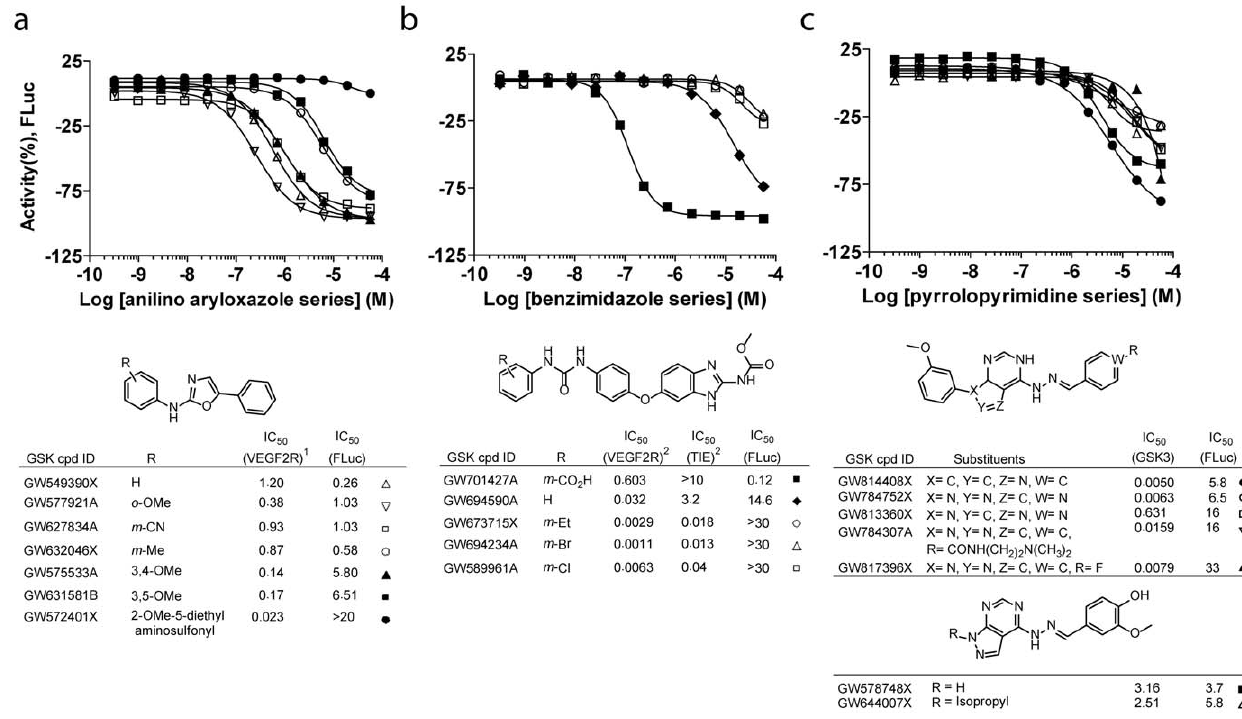
Figure 3. Representative PKIS series displaying FLuc inhibition. ( a ) Anilino-aryloxazole (Cluster 11, Figure 2 ), ( b ) benzimidazole-urea (Cluster 10, Figure 2 ), and pyrrolopyrimidines (Cluster 8, Figure 2 ) analogs displaying different FLuc inhibition SAR patterns. Top, CRC from this study for FLuc inhibition, middle, core scaffold for each series, bottom, activity of each analog against target kinase(s) and FLuc. Data for target kinases taken from references [24,25,30].